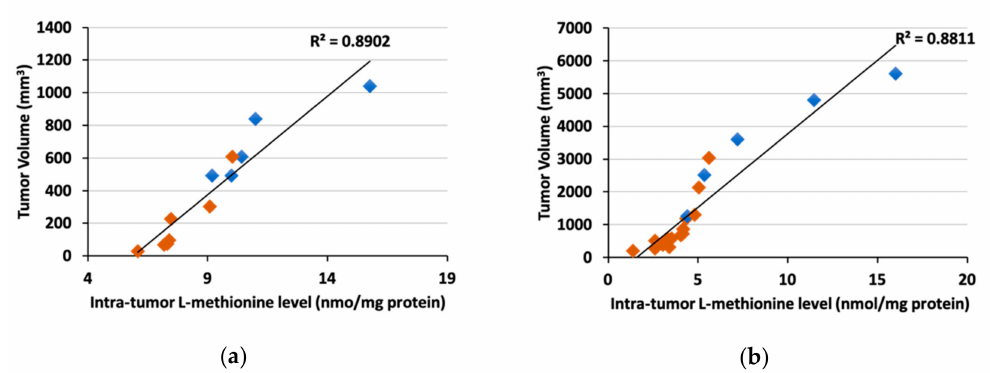
Figure 2. Correlation between tumor volume and methionine (MET) level in pancreatic cancer ( a ) and melanoma ( b ) patient-derived orthotopic xenograft (PDOX). Blue box: Untreated control, red box: Treated with recombinant methioninase (rMETase) [46].